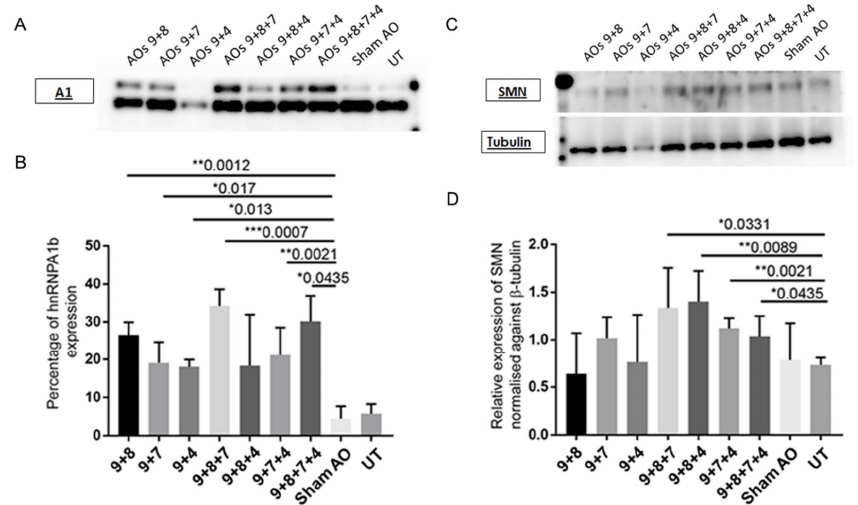
Figure 4. Western blot analysis indicates the hnRNPA1 (34 kDa) and the induced isoform of hnRNPA1 proteins at approximately 38 kDa ( A ), SMN protein at approximately 38 kDa ( C ) and β -tubulin protein at approximately 50 kDa ( C ) expressed in SMA fibroblasts that were transfected with selected seven different AO cocktails, as well as densitometric analysis of percentage of hnRNPA1b ( B ), as compared to SMN protein expression normalised against β -tubulin ( D ). The * symbol indicates the p -value of the average relative protein expression compared to untreated samples (viz * = p < 0.05, ** = p < 0.01 and *** = p < 0.001). We synthesised AOs 9, 4, 7, and 8 as phosphorodiamidate morpholino oligomers to further enhance efficiency of exon skipping, and the different backbone chemistries showed greater biological stability. Most combinations, except for PMOs9 + 4, strongly induced 50 to 60% of hnRNPA1b protein in a cultured SMA fibroblast. PMO cocktails that contain the PMO 7 in the mixture, i.e., PMOs9 + 7, PMOs9 + 8 + 7, PMOs9 + 7 + 4, and PMOs9 + 8 + 7 + 4, caused skipping of SMN2 exon 5 (Figure 5C). None of the PMO cocktails evaluated was found to augment FL ‐ SMN protein expression (Figure 5).